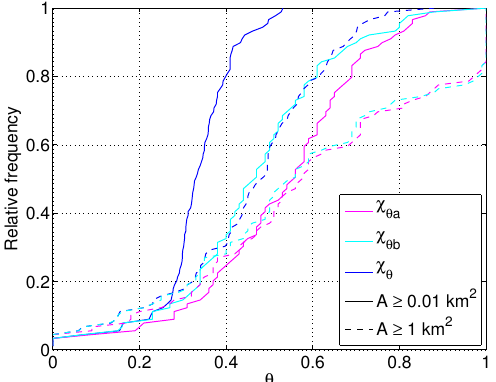
Figure 9. Cumulative distribution of the concavity index θ for the 89 considered catchments in Taiwan. Each curve describes the rel- ative number of the catchments with an estimated concavity index lower than or equal to the value θ on the x axis. Solid lines refer to fits over the entire range 0 . 01 km 2 ≤ A ≤ 100 km 2 , while dashed lines correspond to fits for A ≥ 1 km 2